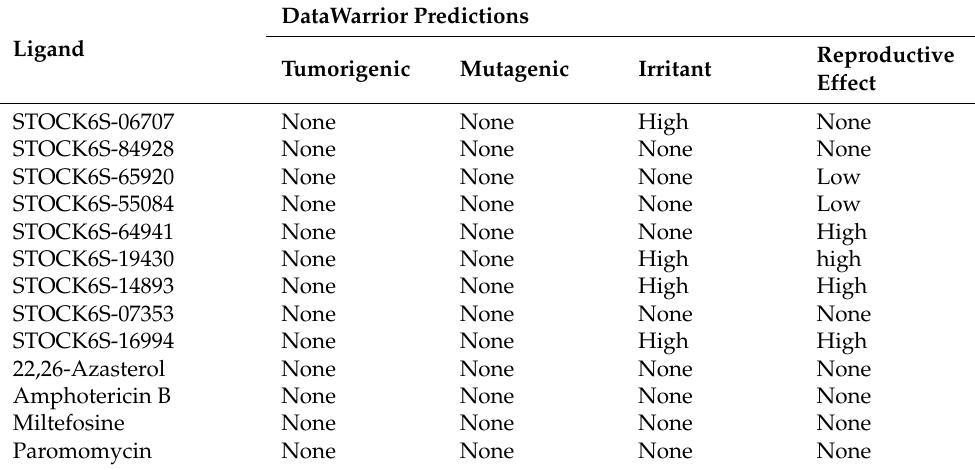
Table 4. Toxicity profiles of the selected compounds predicted using OSIRIS DataWarrior 5.0.0. DataWarrior Predictions Ligand Tumorigenic Mutagenic Irritant